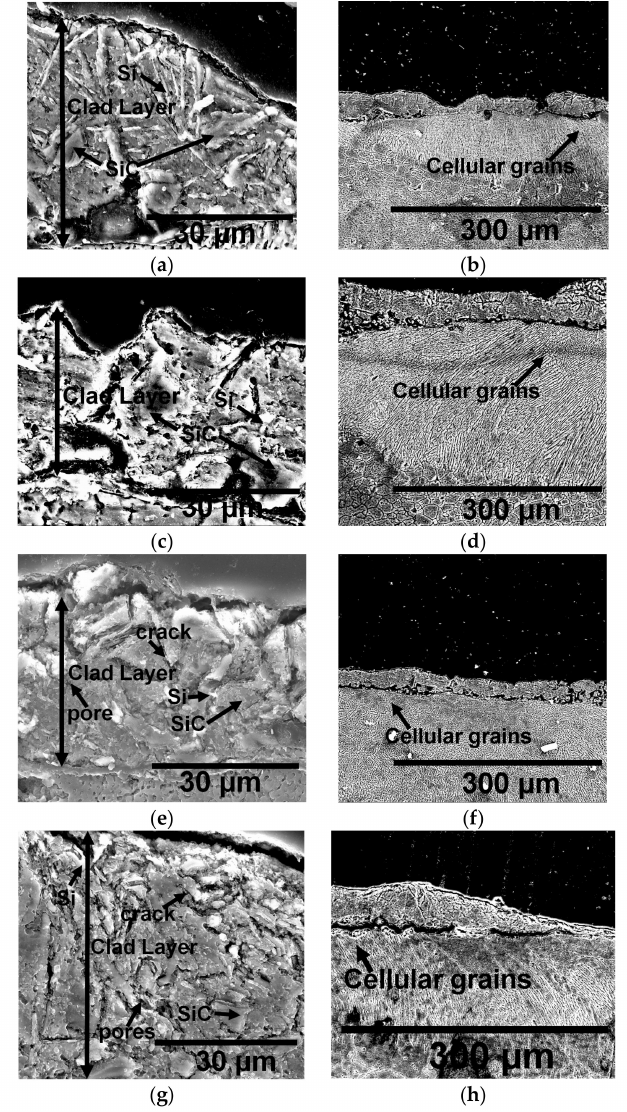
Figure 3. Scanning electron micrographs from laser clad Al-SiC composite surfaces: ( a , b ) laser melted (LM); ( c , d ) laser melted and remelted (RM); ( e , f ) laser melted under the influence of simultaneous influence of ultrasonic vibrations (ULM); and ( g , h ) laser melted and then remelted under the influence of simultaneous influence of ultrasonic vibrations